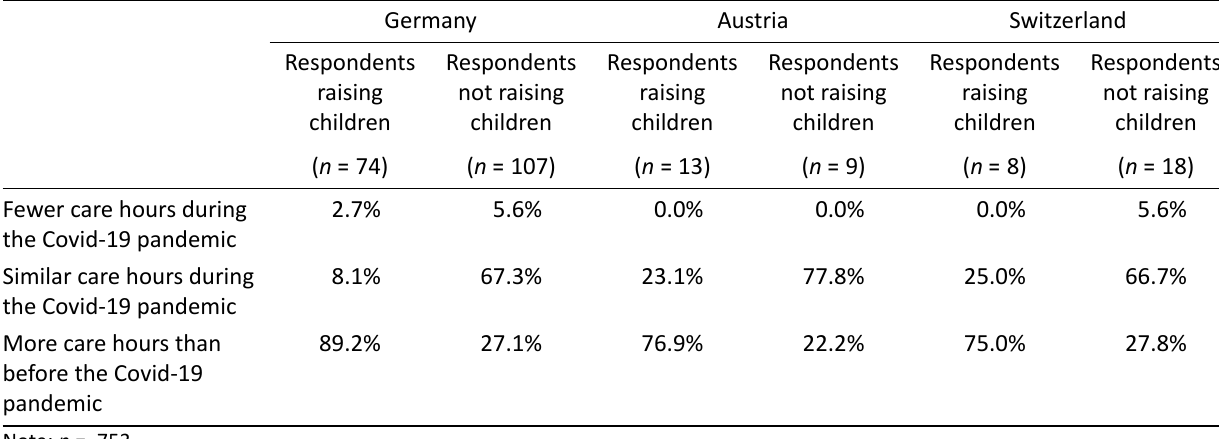
Table 3. Changes in care work during the pandemic in relation to the country of the